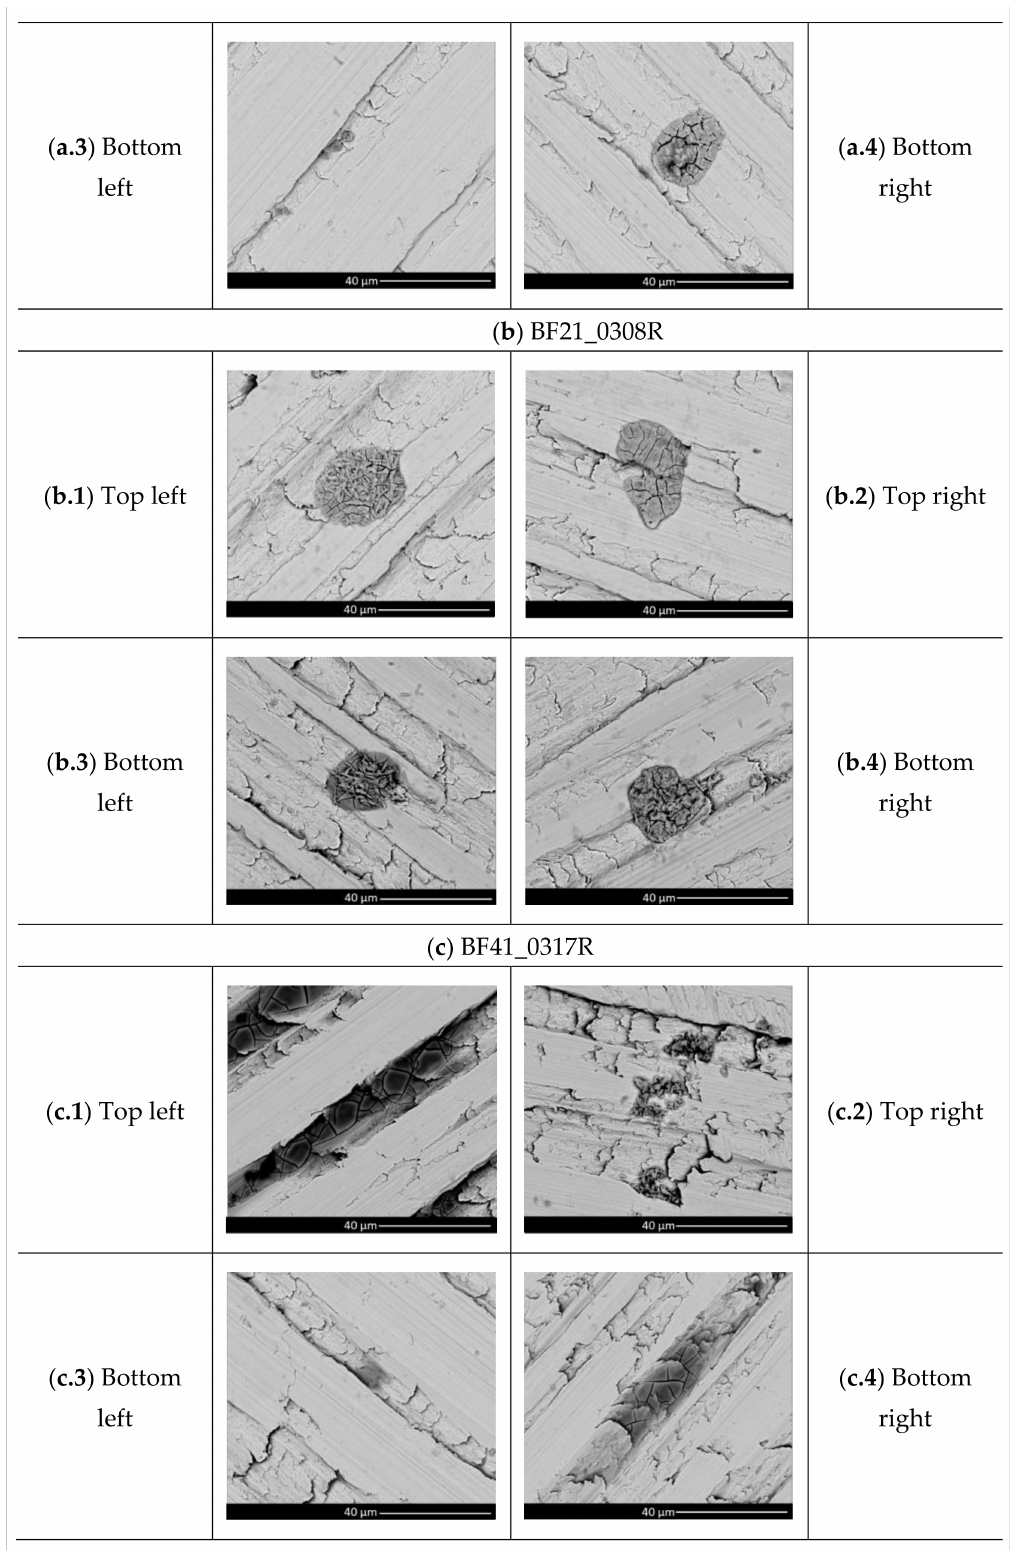
Figure 8. SEM analyses of BF11, BF21 and BF41